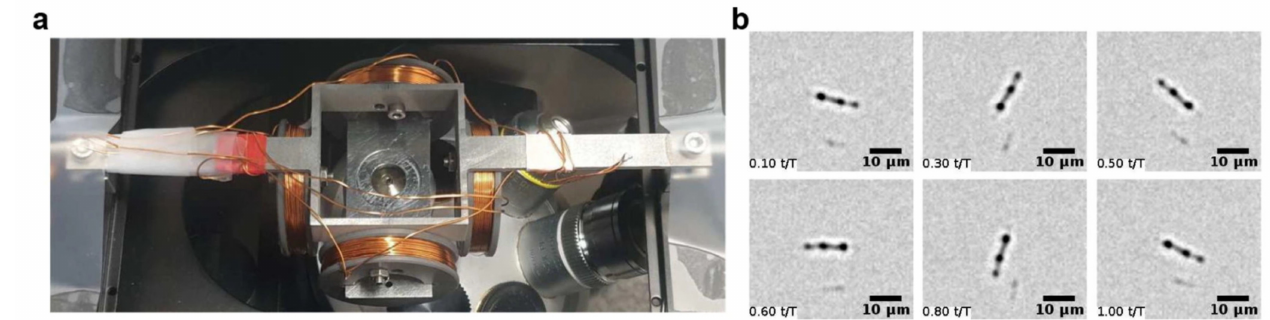
Figure 7. ( a ) The experimental setup for the magnetic mixing system proposed in [93]. ( b ) Snapshots of a rotating magnetic nanobar in a microdroplet in an external rotating magnetic field. Reprinted with permission from P. Gires, et al., 2020. Scientific Reports 10, 10911 [93] under Creative Commons Attribution 4.0 International License http://creativecommons. org/licenses/by/4.0/, accessed on 28 June 2021. Copyright 2020 Springer Nature